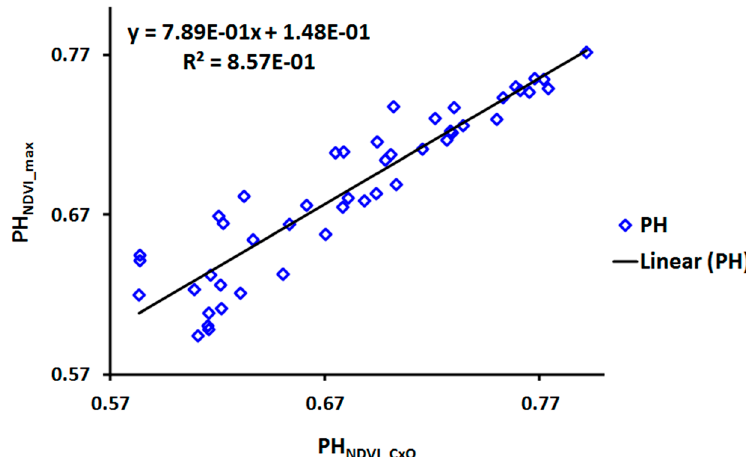
Figure 13. Scatterplot and linear fit between the PH NDVI derived from the CxQ model and the PH NDVI determined by the maximum-value method from the same MODIS dataset for 2003–2010. The linear fit for the PH NDVI from the two approaches of the same dataset was high with R 2 = 0.86. Table 1. Regression results for the linear fits between PH NDVI and PH VOD .